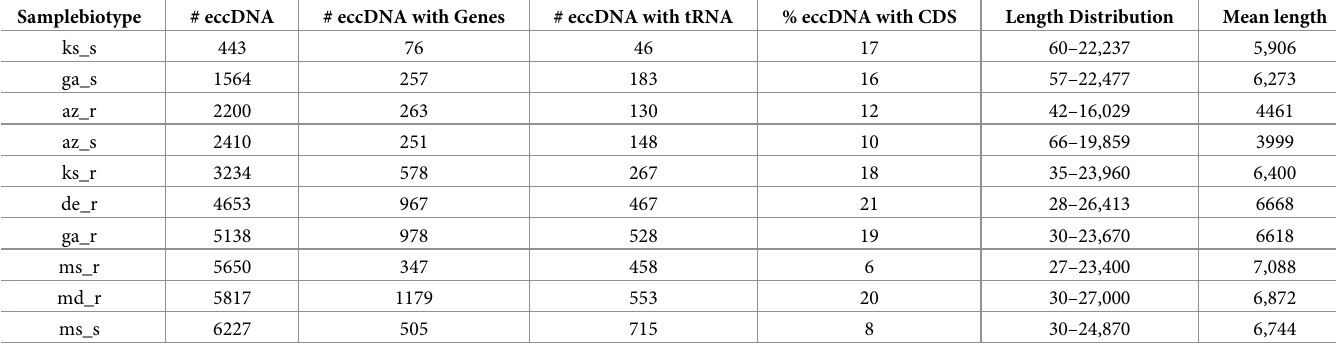
Table 1. EccDNA characterization of GS and GR